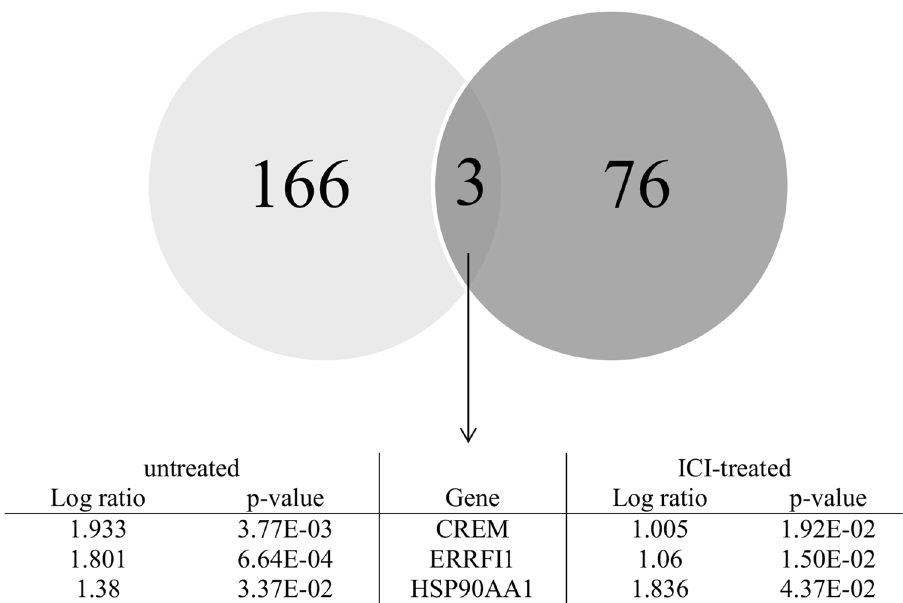
Figure 2. Venn diagram showing the number of disregulated genes by stress based on the comparison of stressed with non-stressed untreated rats (light gray; 4 rats/group), and those stressed and unstressed treated with ICI118,551 (dark gray; 4 rats/group). Only three genes were affected in the two comparisons. The list of affected genes includes name, location, type, p value, and log